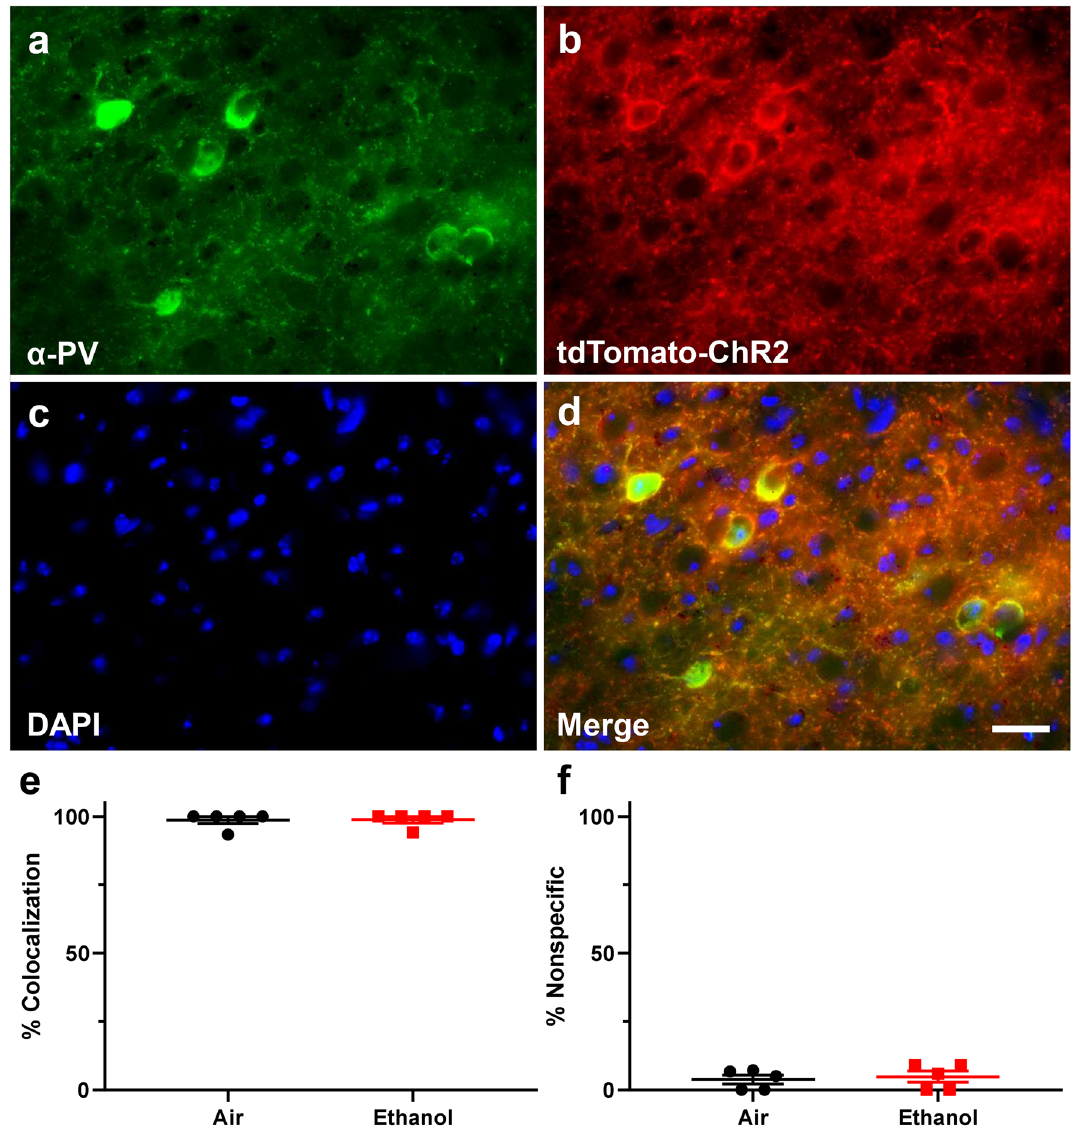
Figure 5. Representative immunohistochemistry (IHC) images from B6 PV cre -Ai27D mice and analysis of both penetrance and specificity of transgene expression. ( a – d ) Representative IHC images showing colocalization of PV and ChR2- tdTomato. ( a ) IHC demonstrating PV expression. ( b ) Expression of endogenous ChR2– tdTomato transgene expression. ( c ) DAPI nuclear stain. ( d ) Merged image. Scale bar 25 µm. ( e ) Penetrance analysis of B6 PV cre -Ai27D transgene expression. Penetrance of transgene expression was measured as the number of PV expressing cells colocalized with tdTomato divided by the number of PV expressing cells. ( f ) Specificity analysis of B6 PV cre -Ai27D transgene expression. Specificity of transgene expression was measured as the number of cells expressing only tdTomato divided by the number of cells expressing both PV and tdTomato. Air male n = 3 animals from 3 litters, air female n = 2 animals from 2 litters; ethanol male n = 3 animals from 3 litters, ethanol female n = 2 animals from 2 litters. Data are presented as mean ±